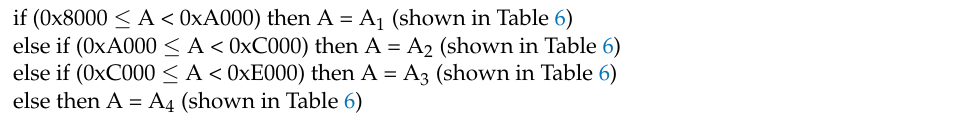
Table 5. MPS and LPS interval subdivision quantization level in case of 4-level.